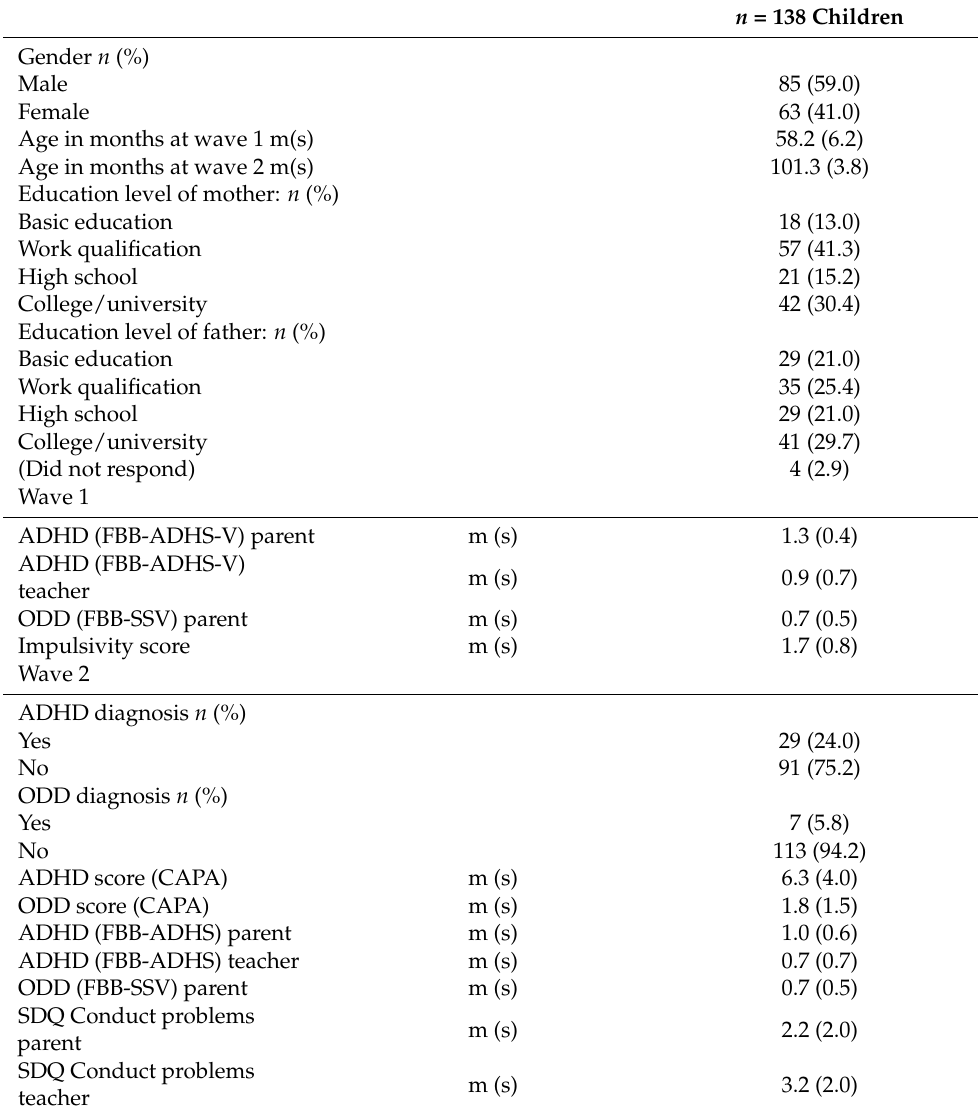
Table 3. Descriptive statistics of Study